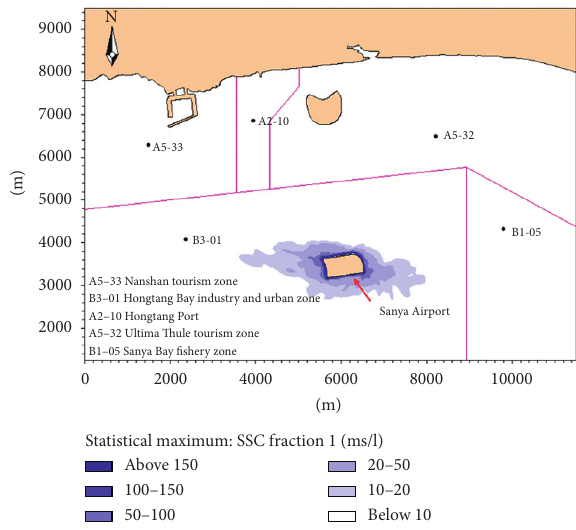
Figure 5: Statistical maximum fraction of suspended solid diffusion.